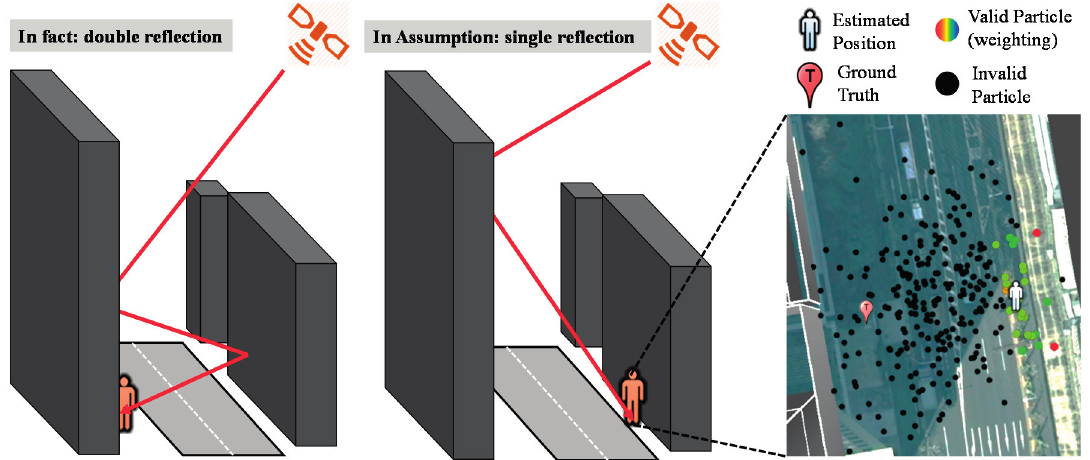
Figure 3. Illustration of the devastated effect caused by double reflected non-line-of-sight